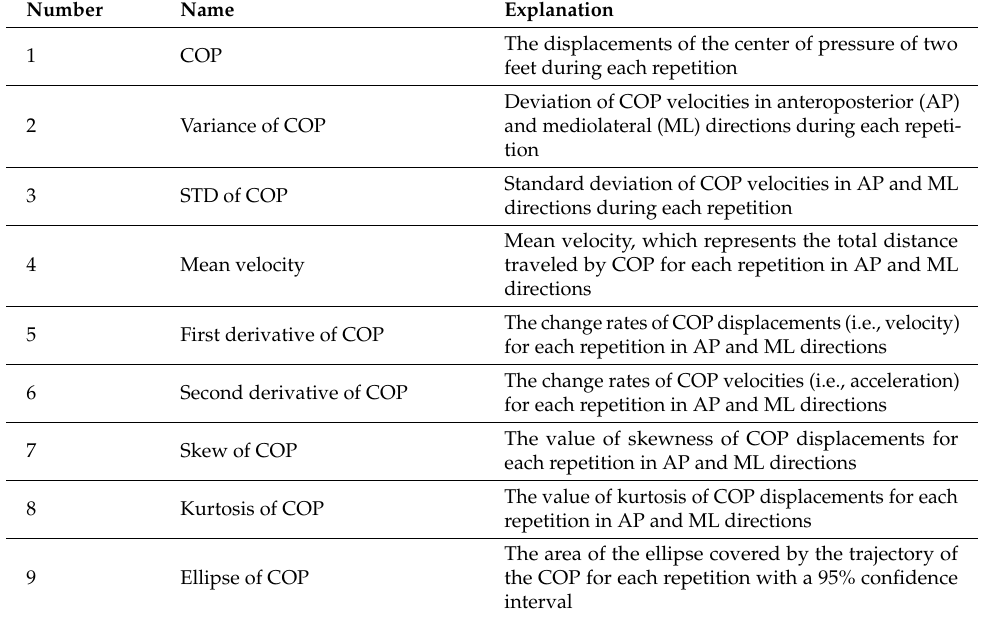
Table 4. Explanation of generated